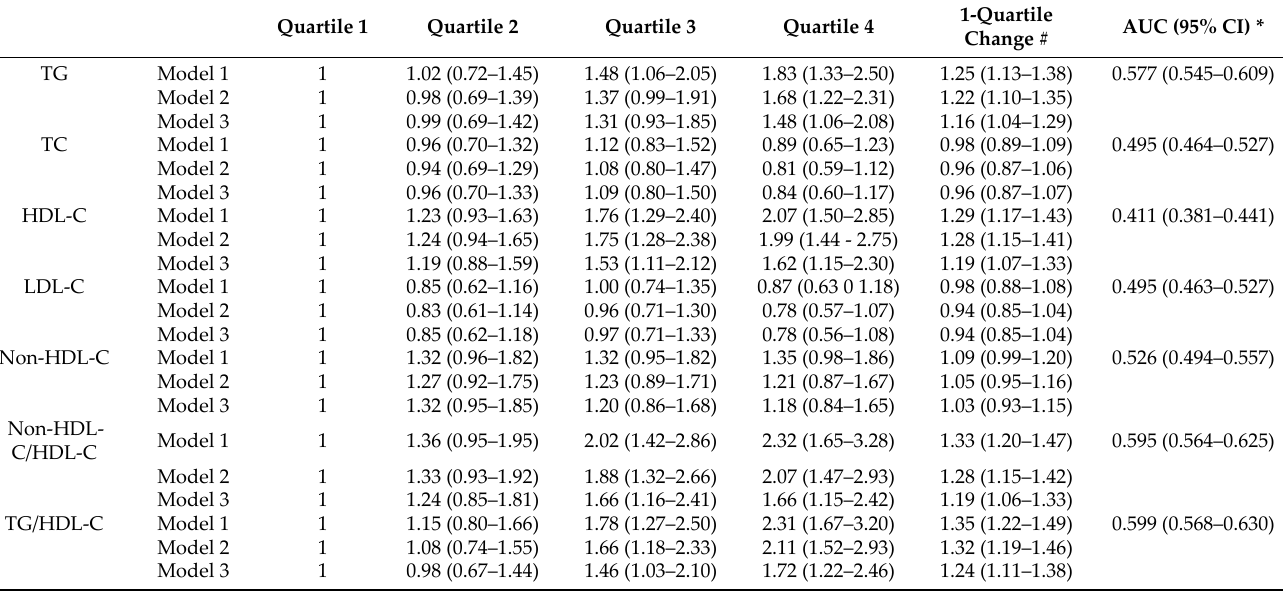
Table 3. Association between baseline lipid parameters and risk of CKD.